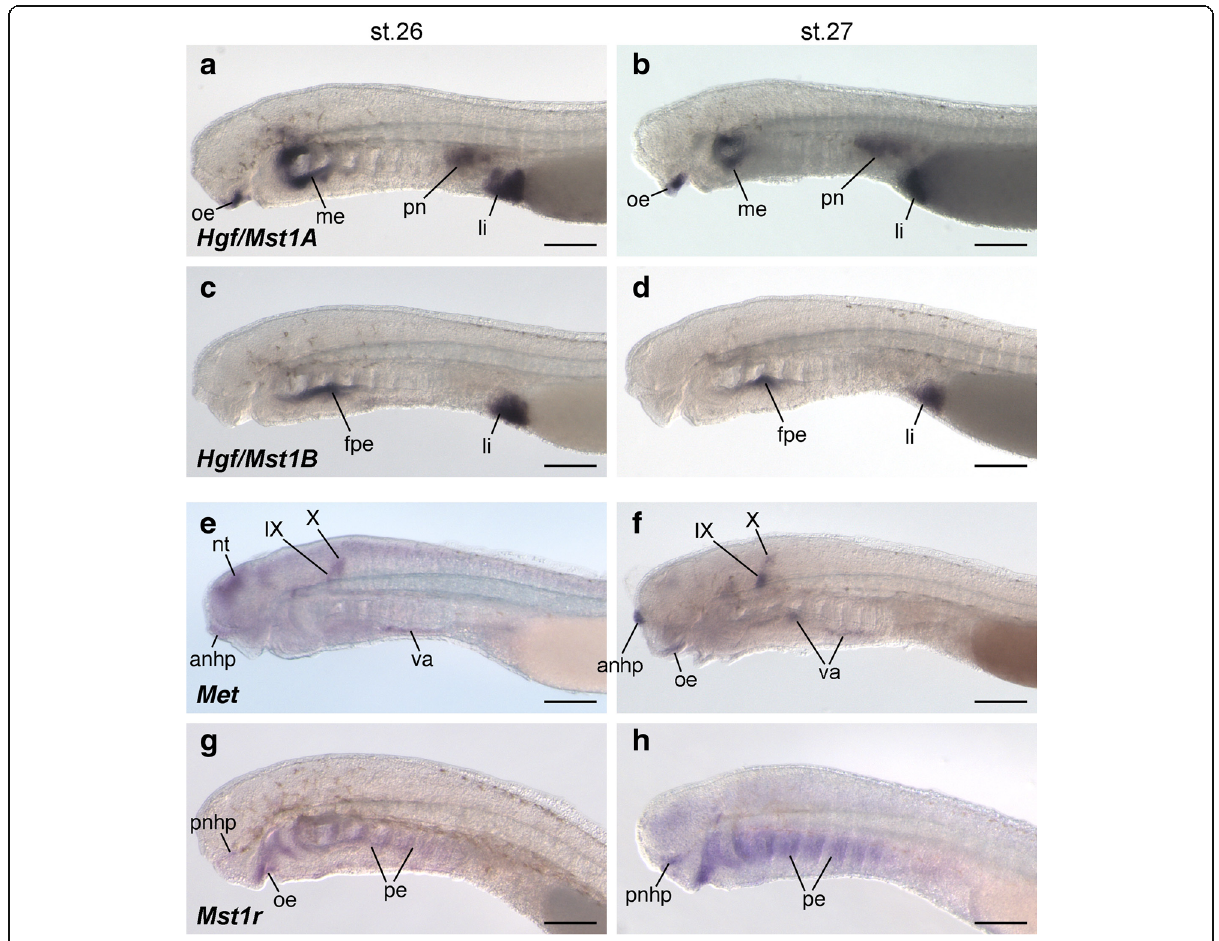
Fig. 4 Expression pattern of Hgf and Met cognate genes in lamprey embryos. Hgf/Mst1A ( a , b ), Hgf/Mst1B ( c , d ), Met ( e , f ), and Mst1r ( g , h ) expression pattern in lamprey embryos at stage 26 ( a , c , e , and g ) and 27 ( b , d , f , and h ). Lateral views. Note that transcripts of Hgf/Mst1A and B genes were not detected in the tissue near the ventral part of dermomyotome, nor in the trajectory of HBM precursors. Met expressions were not observed in somites and HBM precursors. anhp, anterior nasohypophyseal placode; fpe, floor of pharyngeal endoderm; li, liver anlage; me, mandibular arch endoderm; nt, neural tube; oe, oral epithelium; pe, pharyngeal endoderm; pn, pronephros; pnhp, posterior nasohypophyseal placode; va, ventral aorta; IX, glossopharyngeal nerve; X, vagus nerve. Scale bars, 200 μ